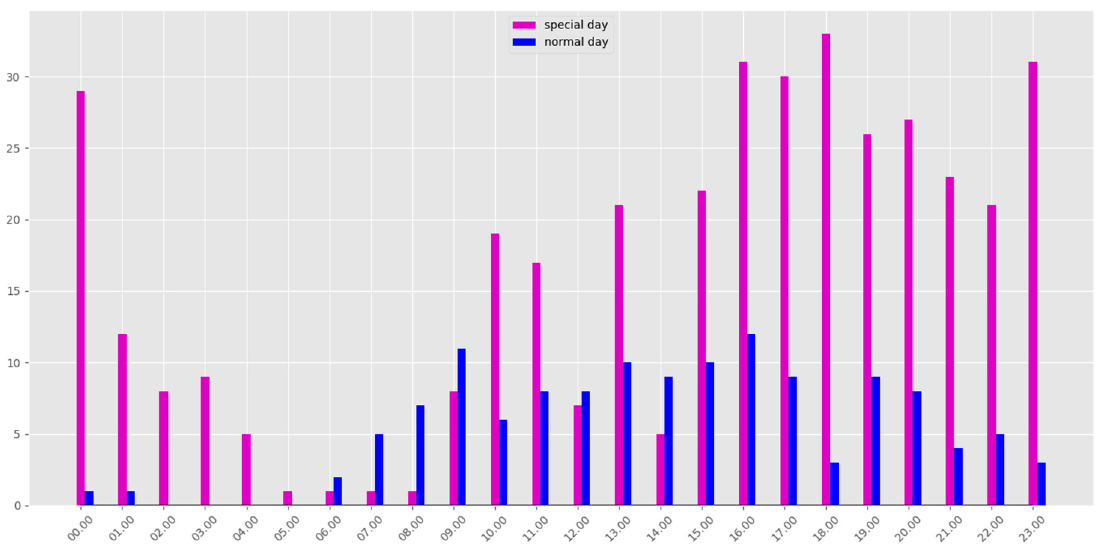
Figure 4. Number of clusters from Puerta del Sol on normal and special days.